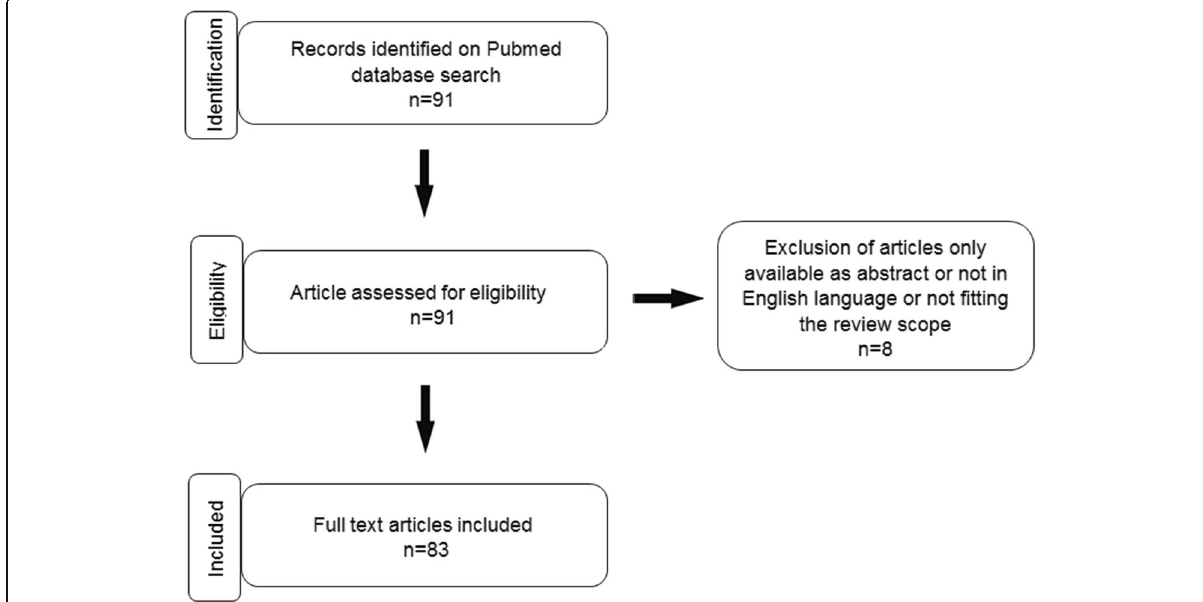
Fig. 2 Flow chart of the search strategy and article selection in this